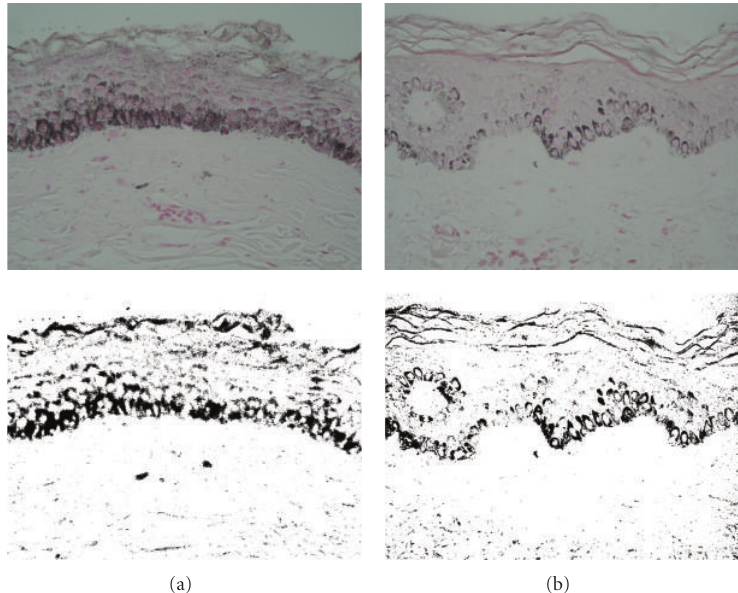
Figure 4: Epidermal pigmentation reduction. (a) Basal melasma skin biopsy, (b) skin biopsy posttreated with niacinamide. (Fontana Masson, original magnification 40x). Below is shown the measured positive areas for melanin using a computer-assisted image analysis program.